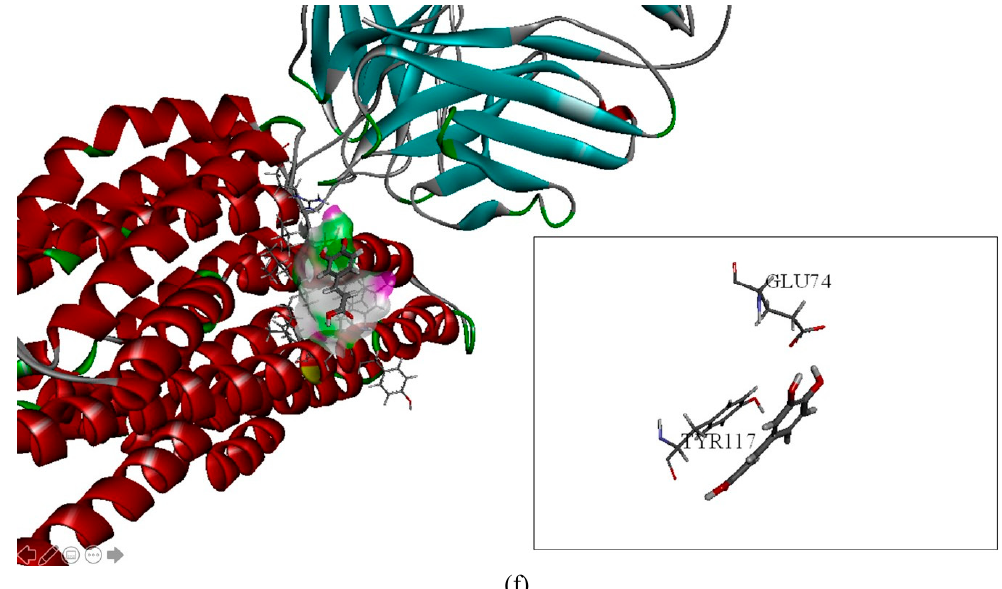
Figure 3. The effects of caffeic acid on human P-gp efflux function. ( a ) Intracellular calcein fluorescence with or without caffeic acid pretreatment in ABCB1 /Flp-In TM -293 cell line (over-expressing human P-gp). ( b ) Michaelis-Menten kinetics of rhodamine123 efflux with or without caffeic acid pretreatment in ABCB1 /Flp-In TM -293. ( c ) Lineweaver-Burk plot analyses of caffeic acid on the transport of rhodamine123 in human P-gp. ( d ) Michaelis-Menten kinetics of doxorubicin efflux with or without caffeic acid pretreatment in ABCB1 /Flp-In TM -293. ( e ) Lineweaver-Burk plot analyses of caffeic acid on the transport of doxorubicin in human P-gp. * denotes p < 0.05 compared with the control group. Data were presented as mean ± SE of at least three experiments, each in triplicate. ( f ) Molecular docking analysis of caffeic acid (PubChem CID: 689043) docked posed of compounds in the P-gp (PDB entry 6QEX) binding pocket of 3D structure.